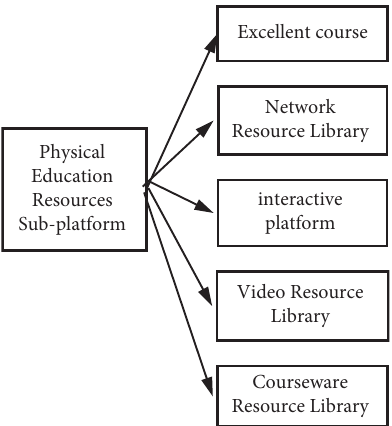
Figure 5: Framework of college physical education teaching re- source subplatform.